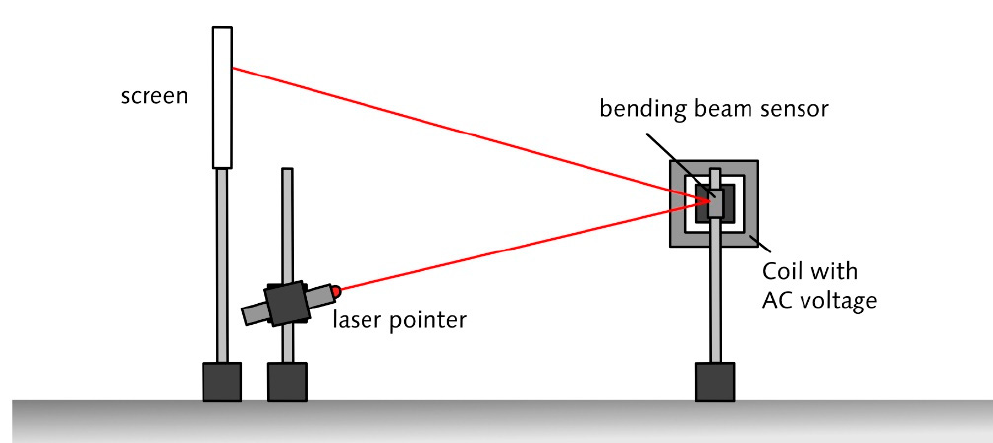
Figure 6. Experimental setup of the bending beam experiment.